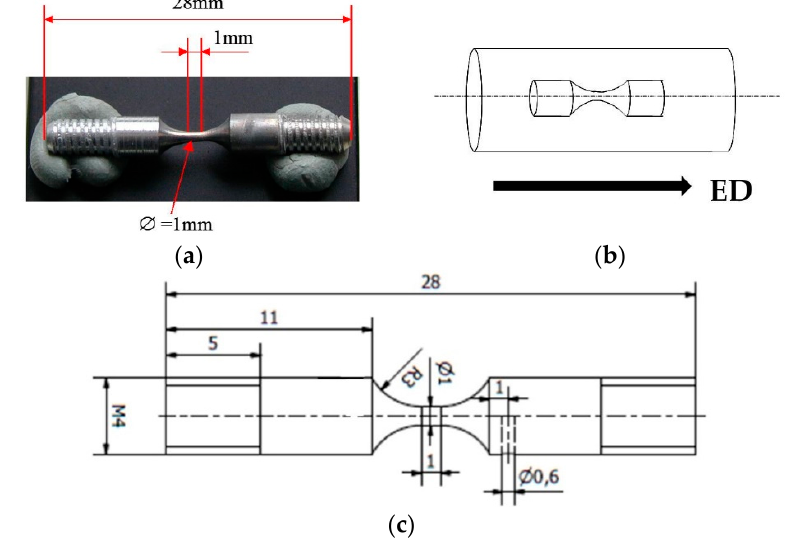
Figure 4. Miniature creep specimen: ( a ) main geometry; ( b ) extrusion direction (ED); ( c ) engineering detail drawing .